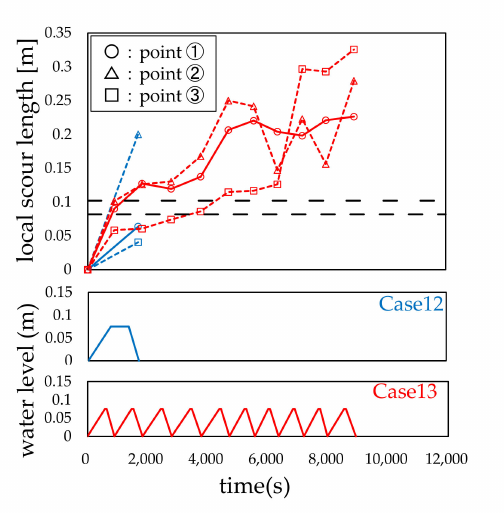
Figure 18. Local scour length of Cases 12 and